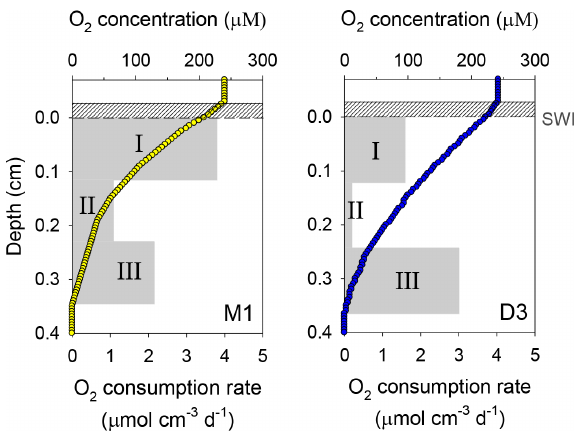
Figure 3. Vertical profiles of O 2 . The slashed area indicates the dif- fusive boundary layer in the sediment–water interface (SWI). The shaded areas indicate O 2 consumption by aerobic respiration (I and II) and re-oxidation of reduced inorganic compounds